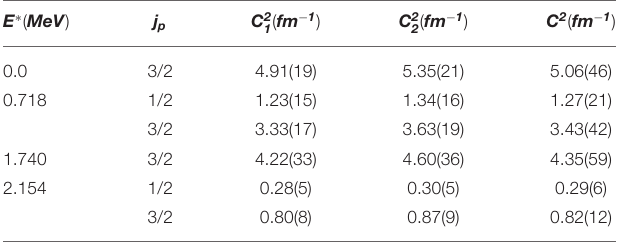
TABLE 1 | The extracted ANCs( C 2 ) for the 9 Be(p, γ ) 10 B capture from the 9 Be( 10 B, 9 Be) 10 B reaction.